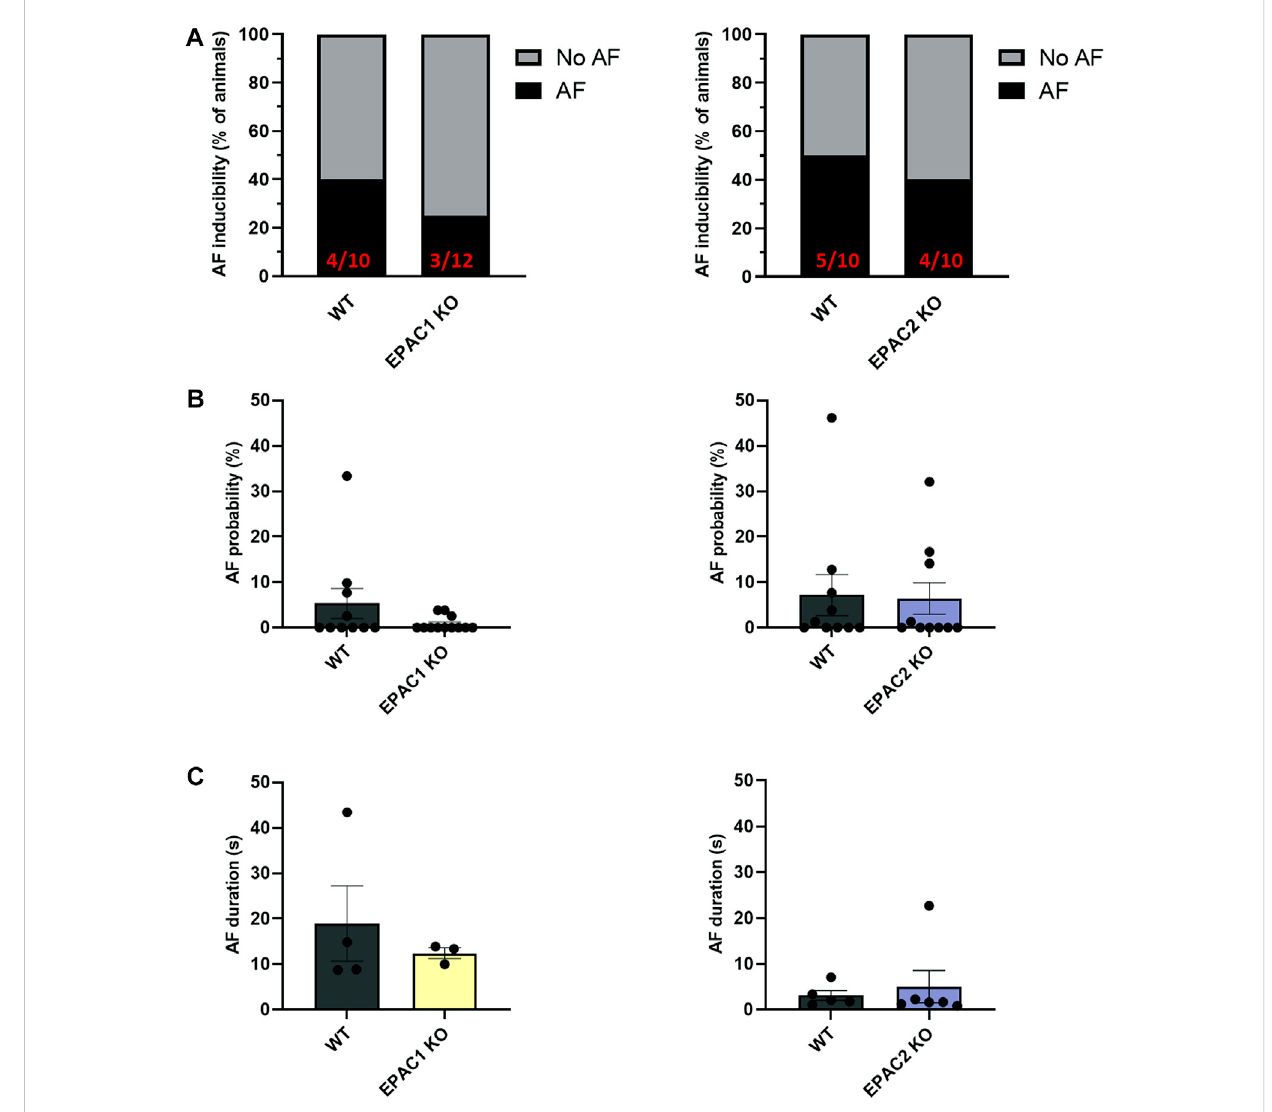
FIGURE 2 Impact of EPAC1 and EPAC2 expressions on AF. (A) AF vulnerability. (B) AF probability. (C) AF episode duration. Statistical differences were determined by Fisher ’ s exact tests (A) and Mann Whitney (B,C) ; N = 10 WT, 12 EPAC1 KO, 12 EPAC2